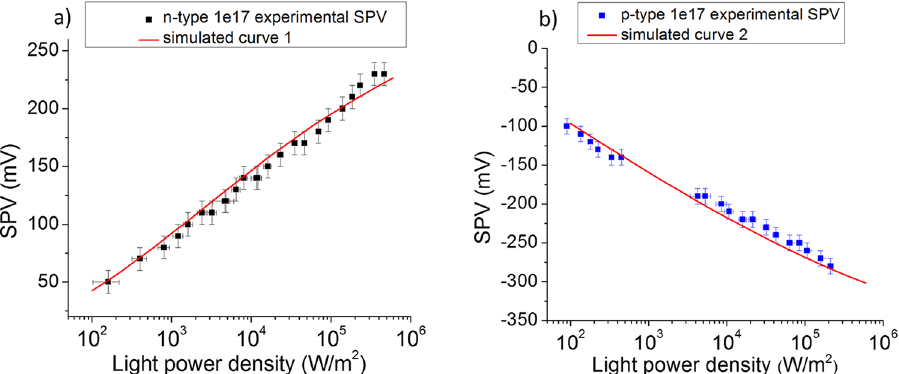
Fig. 3. Measured and simulated surface photovoltage on crystalline (111) silicon doped (a) n-type NA= 10 17 cm (cid:1) 3 and (b) p-type ND =10 17 cm (cid:1) 3 . A good match between focused and defocused illumination is achieved. Modelling shows a good match with the experimental data in both